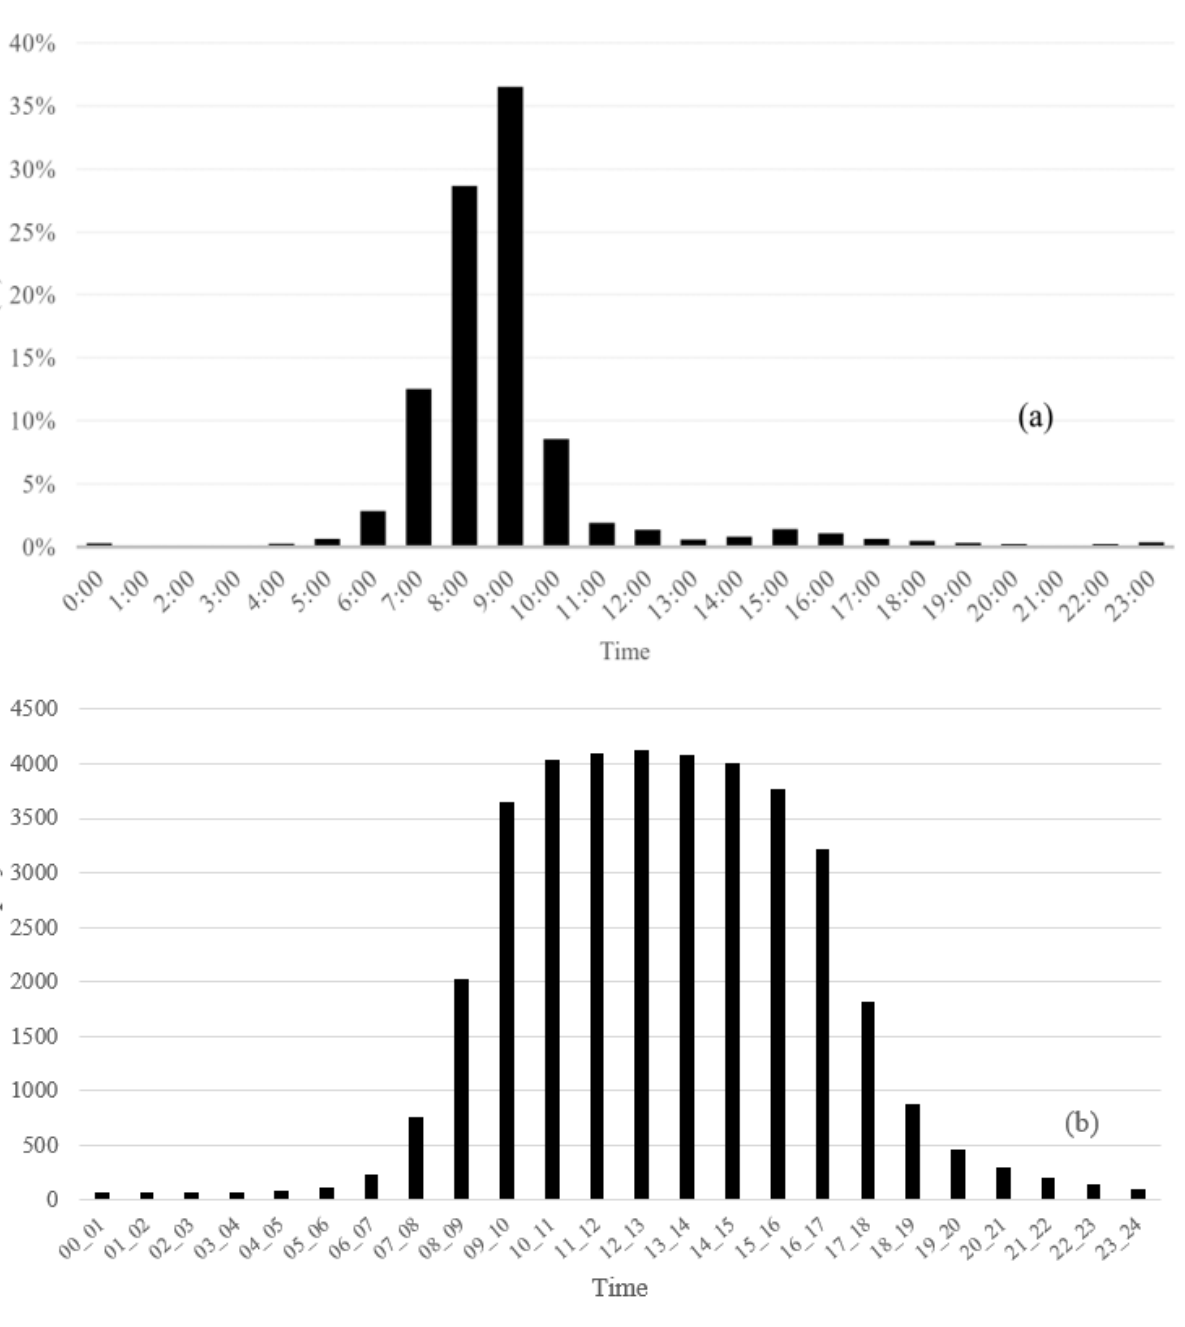
Figure 6. Statistical analysis of the target group: ( a ) work start time distribution, ( b ) employee × hour distribution.